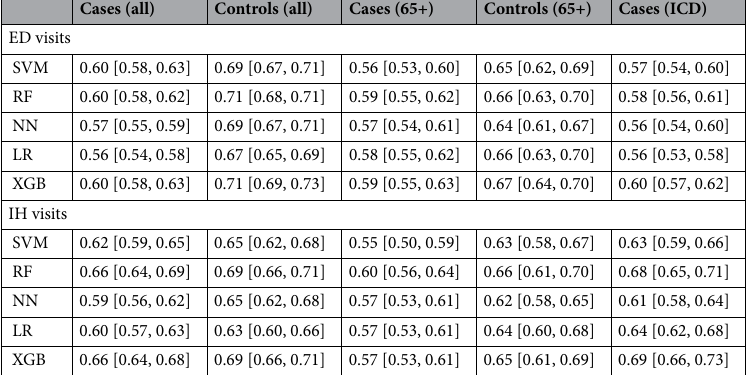
Cases (all) Controls (all) Cases (65+)